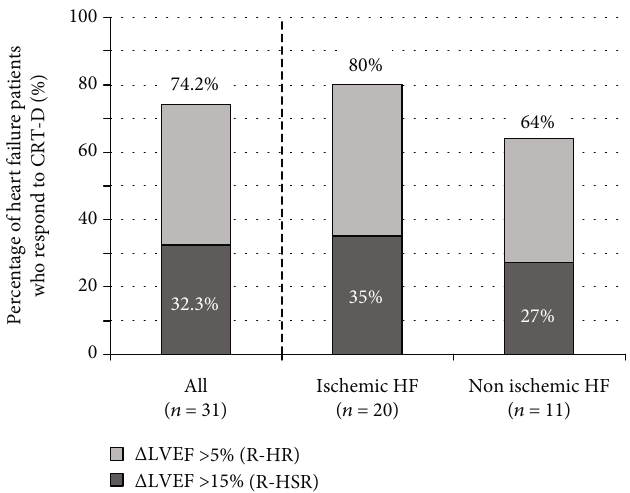
Figure 2: Rate of hemodynamic response ( Δ LVEF > 5 %) and super-response ( Δ LVEF > 15 %) in all patients (left), patients with ischemic heart failure (center), and patients with nonischemic heart failure (right) at 6 months follow-up. Abbreviations: CRT-D: cardiac resynchronization therapy-de fi brillator; HF: heart failure; LVEF: left ventricular ejection fraction; R-HR: rate of hemodynamic response; R-HSR: rate of hemodynamic